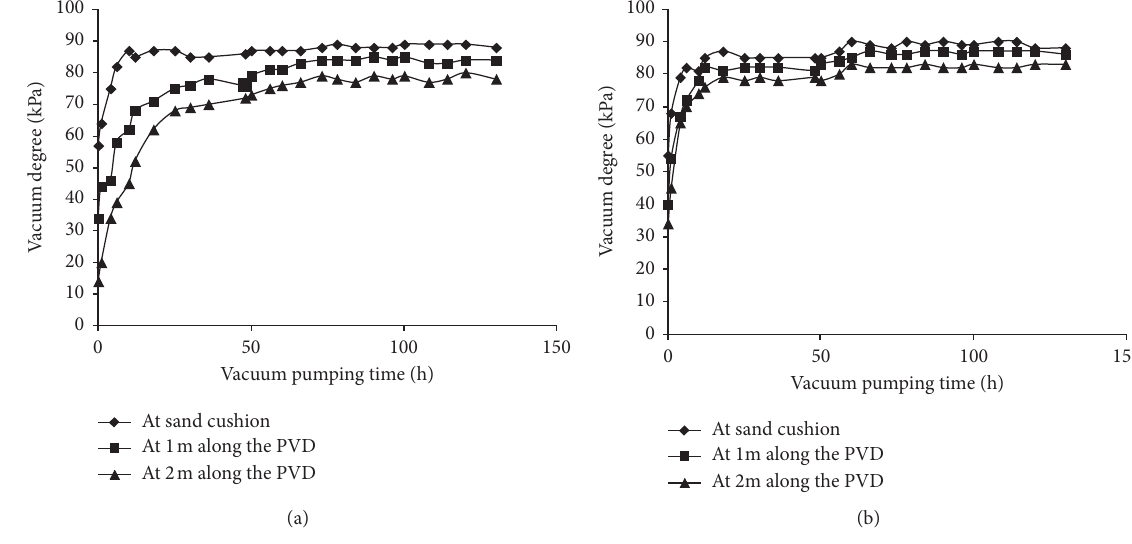
Figure 6: Vacuum degree at different depths: (a) common PVD; (b) new